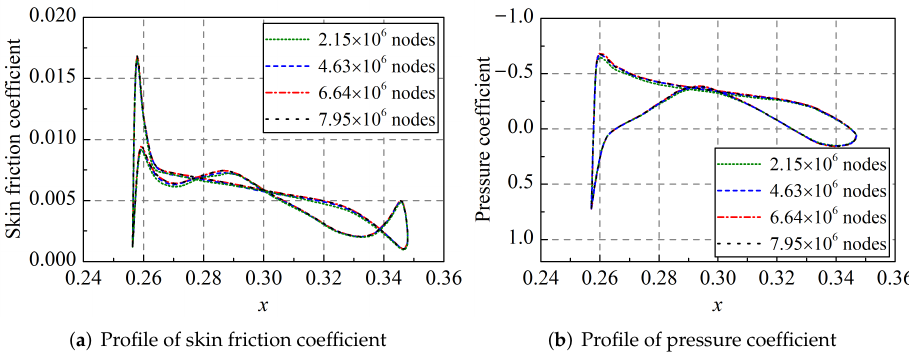
Figure 15. Result of grid independence validation on skin friction coefficient and pressure coefficient.